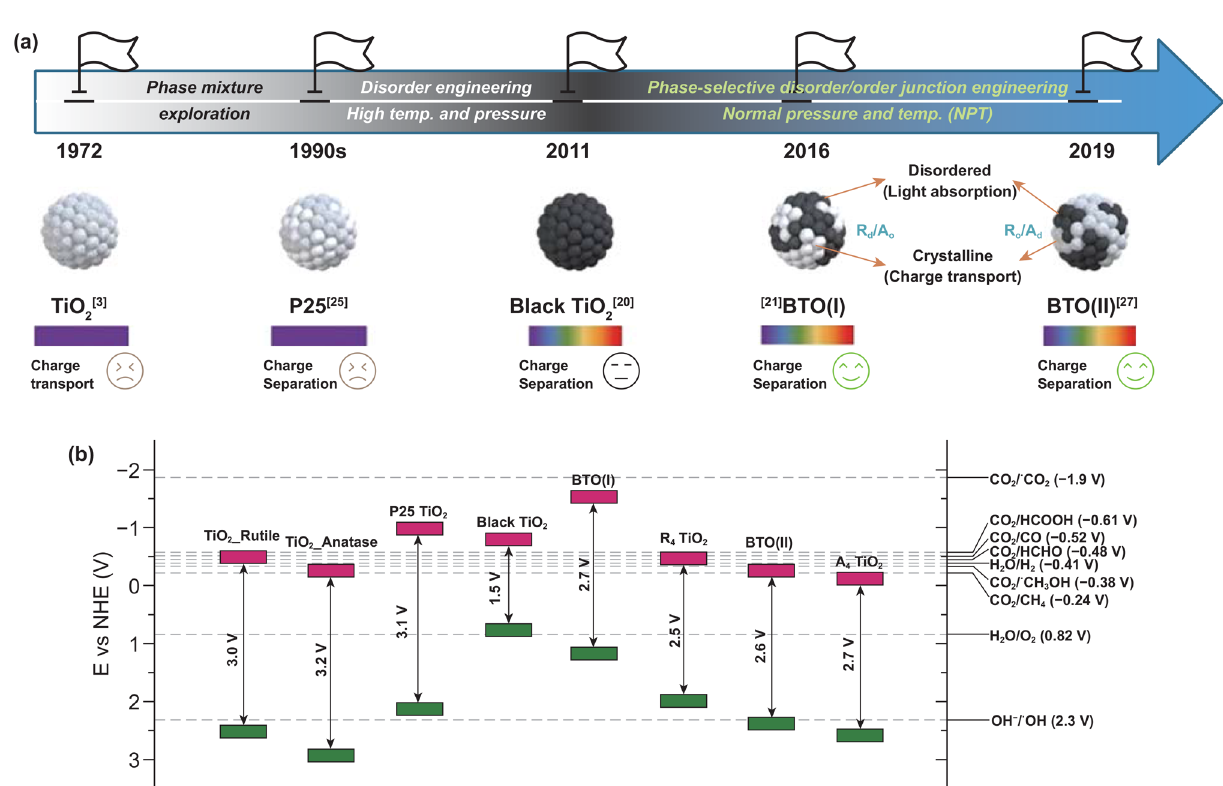
Fig. 1 a Milestones in TiO 2 material development and b the corresponding band structure of each typical TiO 2 configuration [3, 20, 21, 25, 28, 32]. The TiO 2 nanoparticles illustration figures in ( a ) are adapted with the permission from Ref. [28]. Copyright (2019) American Chemical